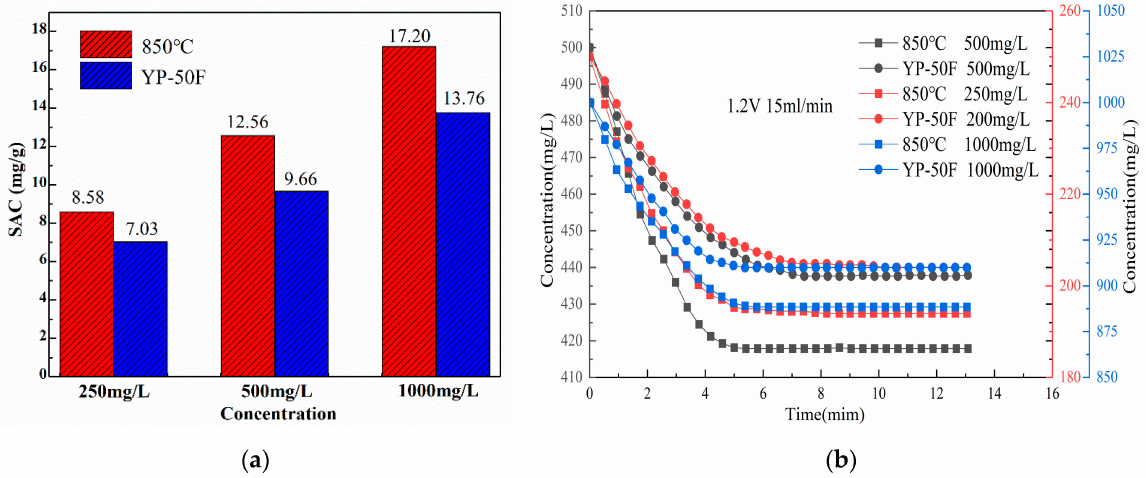
Figure 15. ( a ) SAC of YP-50F and N-doped layered porous carbon at 850 ◦ C pyrolysis temperature. ( b ) Concentration-time curves of N-doped layered porous carbon at YP-50F and 850 ◦ C pyrolysis temperature under different concentration